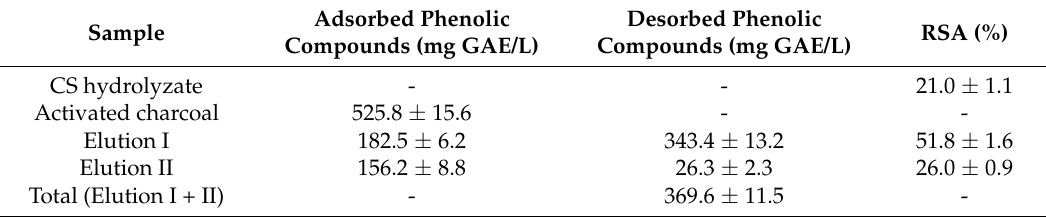
Figure 2. Desorption yield of phenolic molecules from 5% ( w / v ) AC, after CS hydrolyzate detoxification, testing several eluent mixtures containing alcoholic or alkaline solutions. Standard deviation ( n = 3) is indicated by the error bars. Table 1. Phenolic compounds desorption from activated charcoal (AC) and radical scavenging activity (RSA). The phenolic compounds were eluted from AC with 2 M NaOH/ethanol (1:1 v / v ). The eluates and the hydrolyzate, containing 20 µg GAE, were analyzed for RSA (Section 3.7).